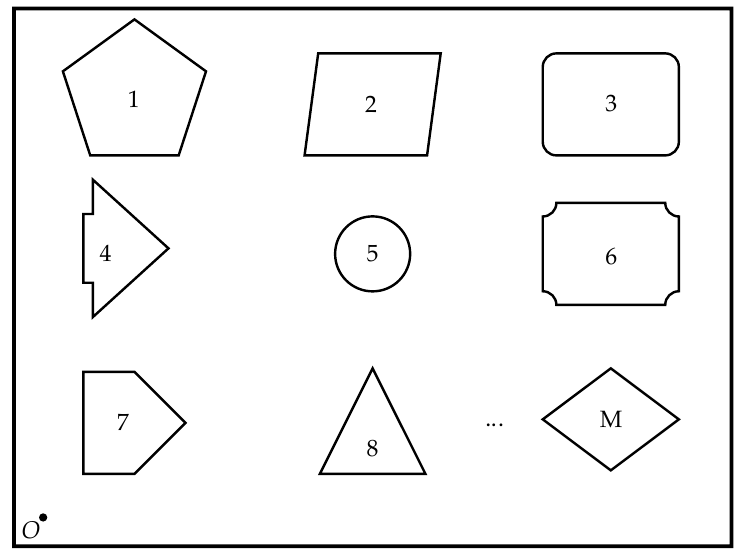
Figure 4. Layout of parts.